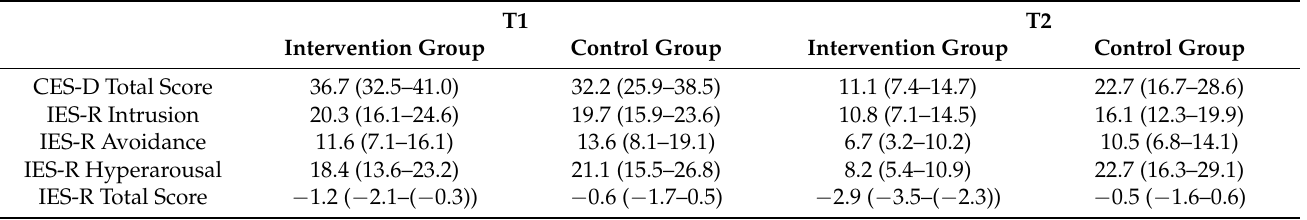
Table 2. Total CES-D scores and total and subcategories IES-R scores (95% confidence interval) of mothers of preterm infants with and without music therapy one week after birth (T1) and at the infants’ discharge from hospital (T2). T1